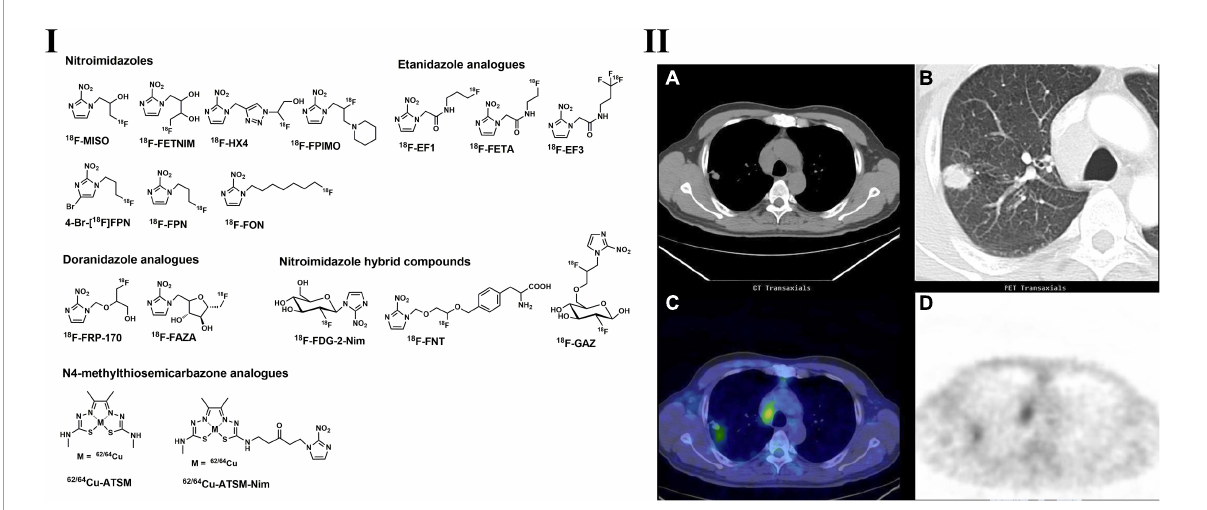
FIGURE2 Structures of representative PET tracers for tumor hypoxia (I) and typical PET and CT images of 62 Cu-ATSM in patient with lung adenocarcinoma (II) . (IIA,B) CT images indicated the mediastinal lymphadenopathy and lung tumor located in right upper lobe; (IIC,D) 62 Cu-ATSM PET and PET/CT images shows high radioactivity accumulation in the enlarged lymph node and lung tumor.